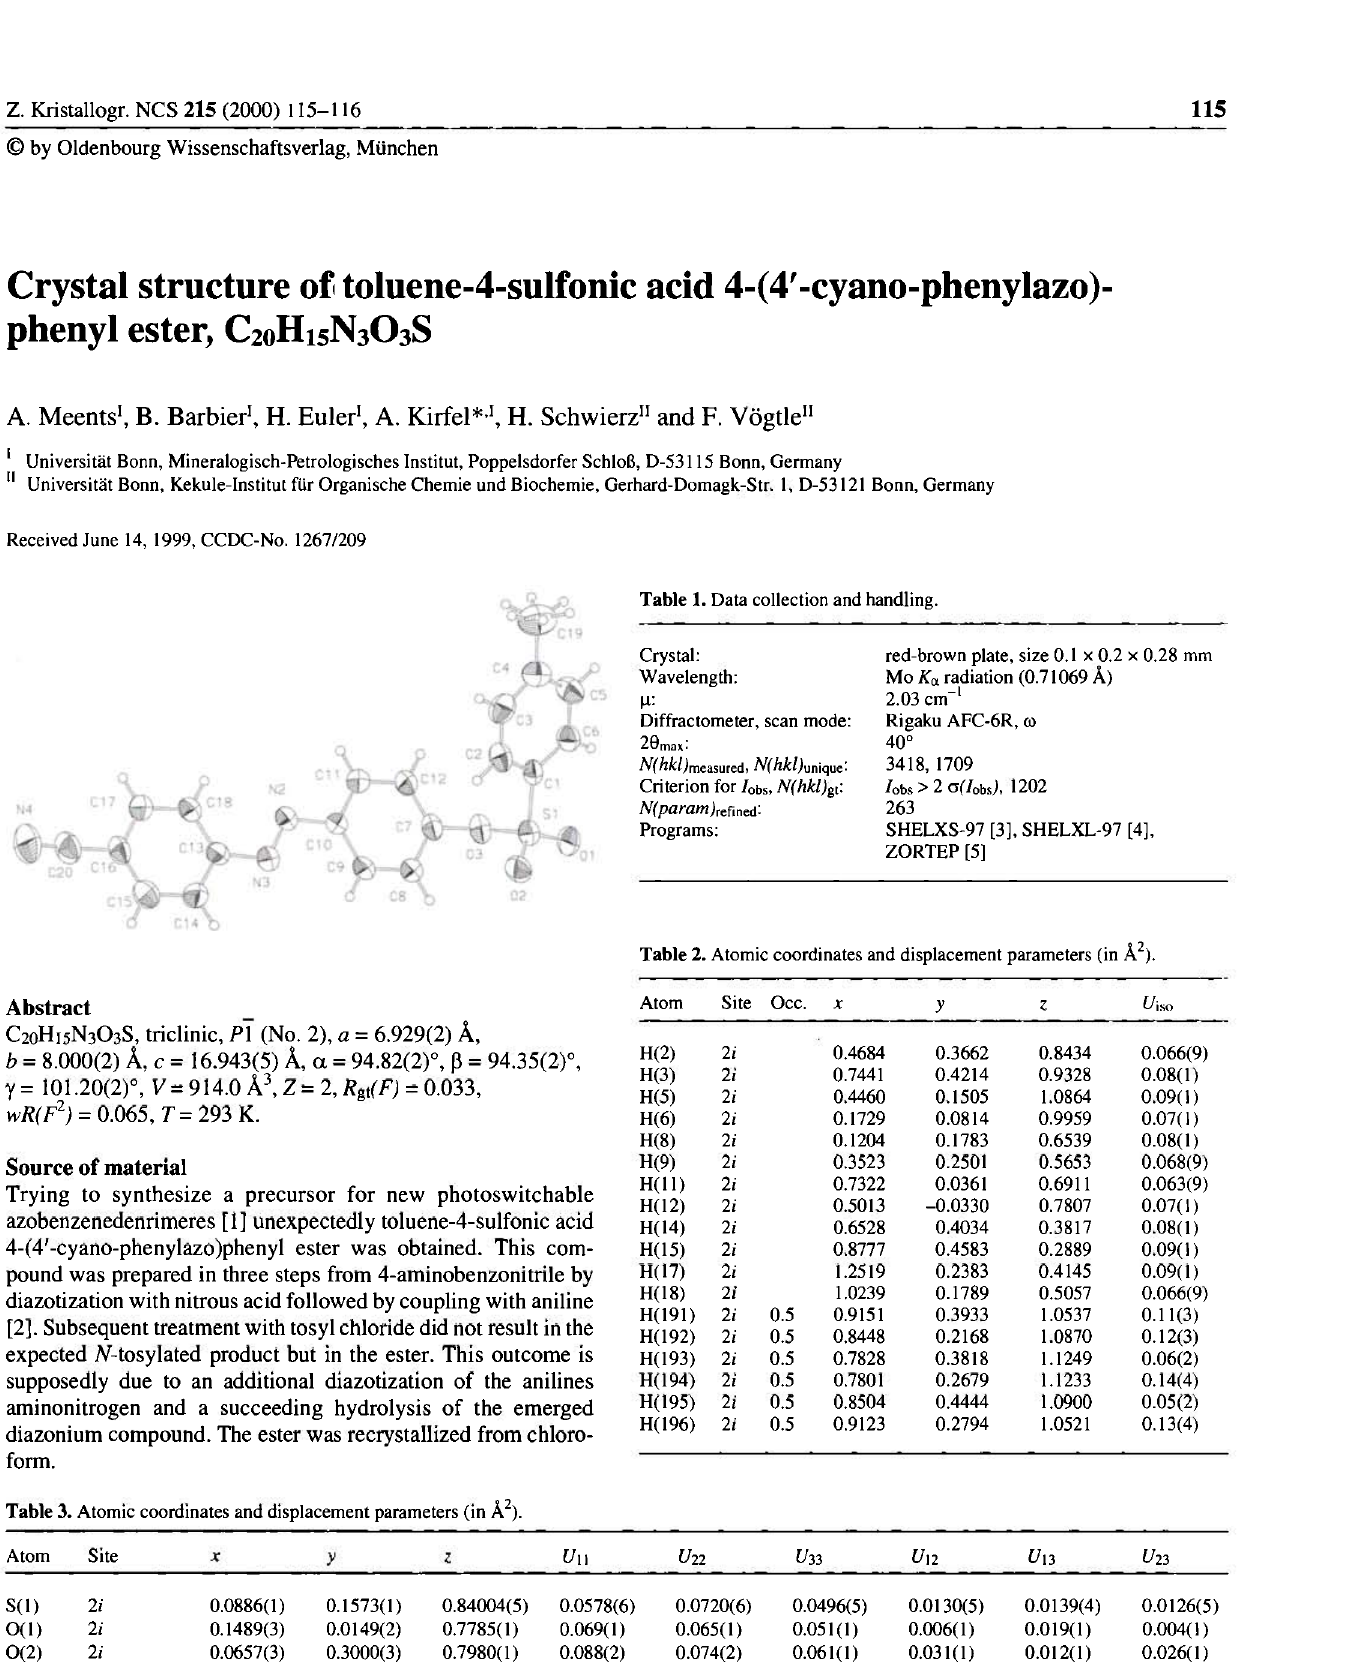
Table 3. Atomic coordinates and displacement parameters (in Ä 2 ).